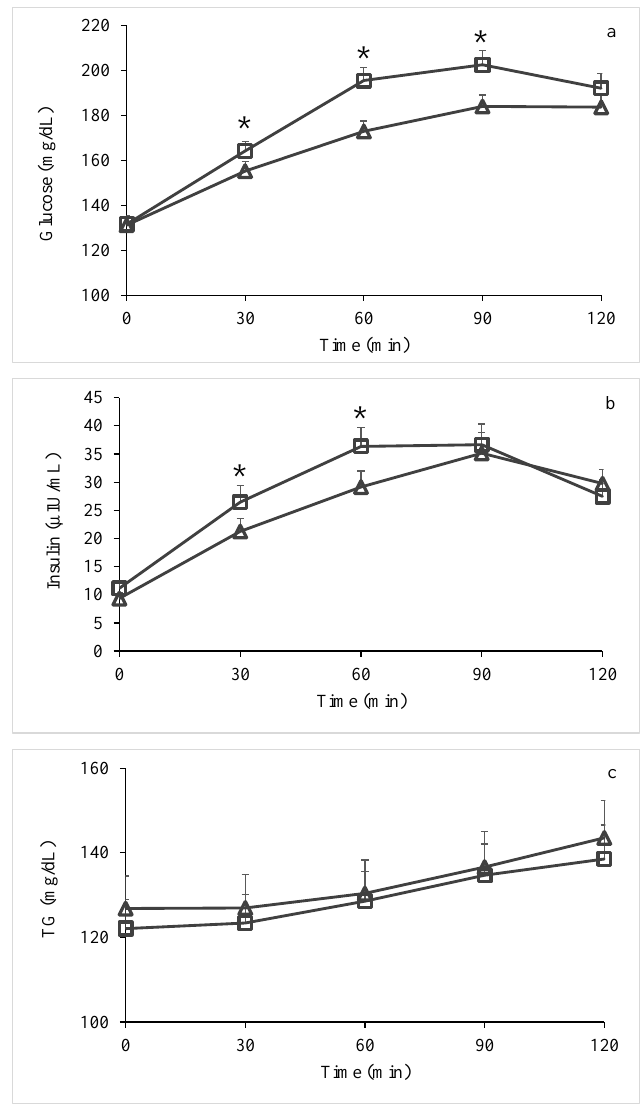
Figure 1. Serum glucose ( a ), serum insulin ( b ), and serum triglycerides ( c ) (mean ± SEM) following consumption of low-GI / GL dessert ( ∆ ) and conventional dessert ( (cid:3) ). Statistical significance ( p < 0.05) between response to low-GI / GL dessert and control is indicated by